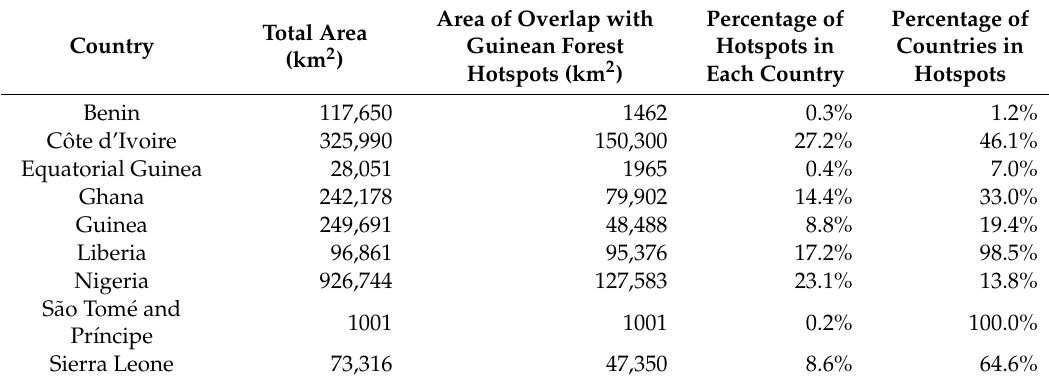
Table 1. Total area and proportion of hotspots in West African countries. Area of Overlap Country